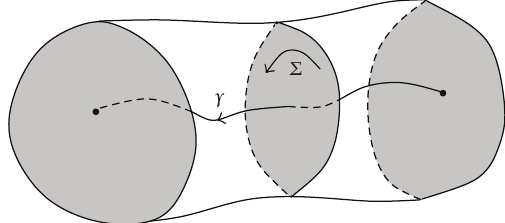
Figure 2: Representatives of dual